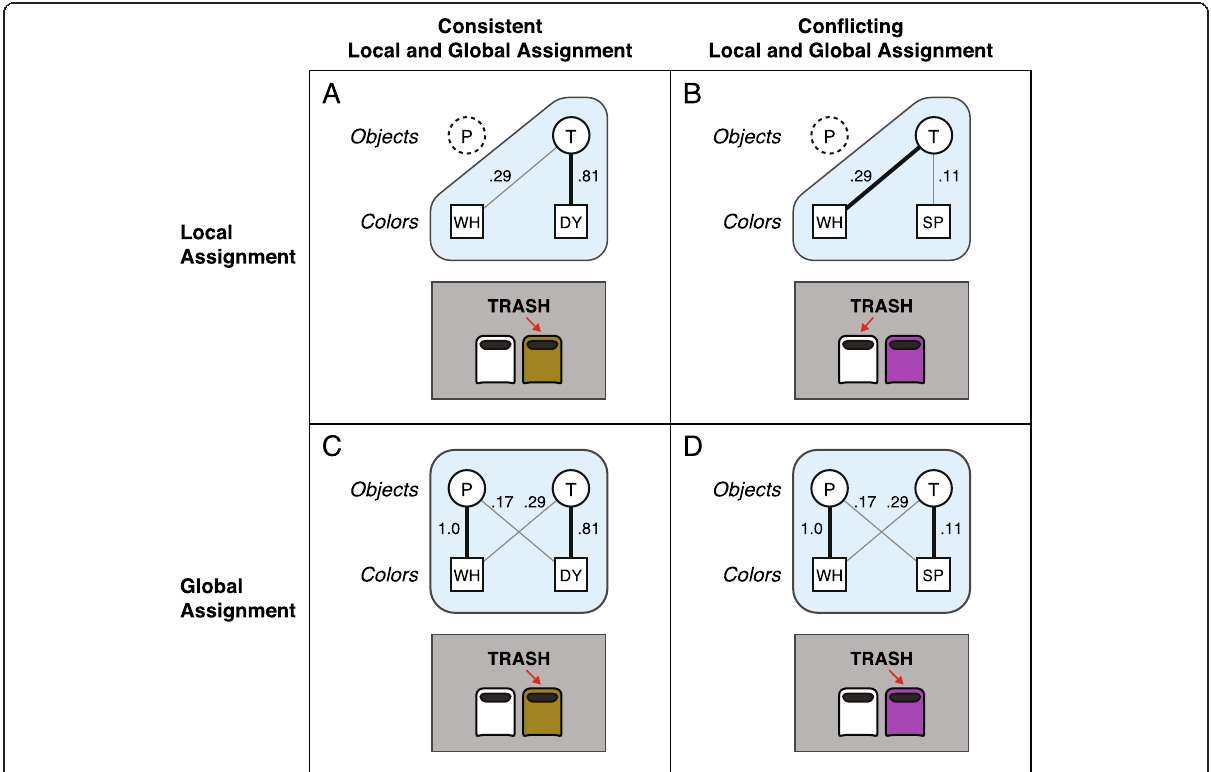
Fig. 5 Illustration of the assignment inference process for two objects and two colors, under the local assignment ( a and b ) or global assignment ( c and d ) hypotheses. Thick black lines represent assigned color-object pairings and thin gray lines represent unassigned color-object pairings. Under local assignment, the target object (trash) is matched with its strongest associate (association ratings indicated on the graph edges). This means assigning trash to DY in the WH/DY color set ( a ) and assigning trash to WH in the WH/SP color set. Under global assignment, the target is matched by accounting for the association strengths of both objects and both colors. This means assigning trash to DY in the WH/DY color set ( c ) as in ( a ), but assigning trash to SP in the WH/SP color set ( d ), even though trash has a higher association rating with WH than with